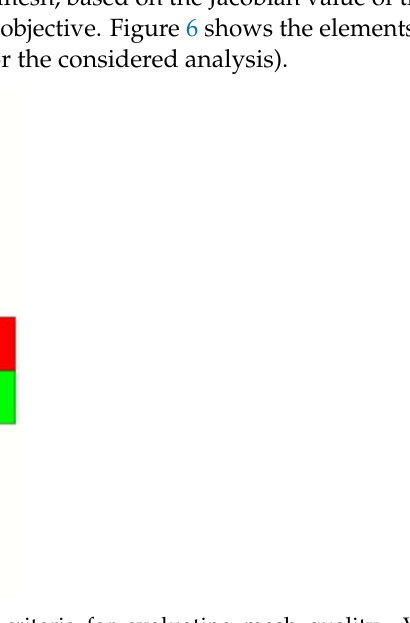
Figure 7. Boundary condition, muscles fixing scapula ( left ), constrain in FEA model, ( right ), scapula fixed. 2.1.6. Load Application In order to be able to validate results of the analysis, the load considered must be easy to replicate in a controlled environment; that is why we have defined the load as the mass of a dumbbell of 15 kg (approximately, 150 N) for the biceps analysis. In the case of triceps loading, the simulation is more similar to the exercise done using a guided load machine. The application point of this load is the wrist (the hand is not modeled) and although this can affect slightly to the results, due to the difference in distance of the load applied in the joint, this can be solved varying the load as needed when applied in the hand. All models have the same load applied, at the same node, and in the same vertical direction (see Figure 8).